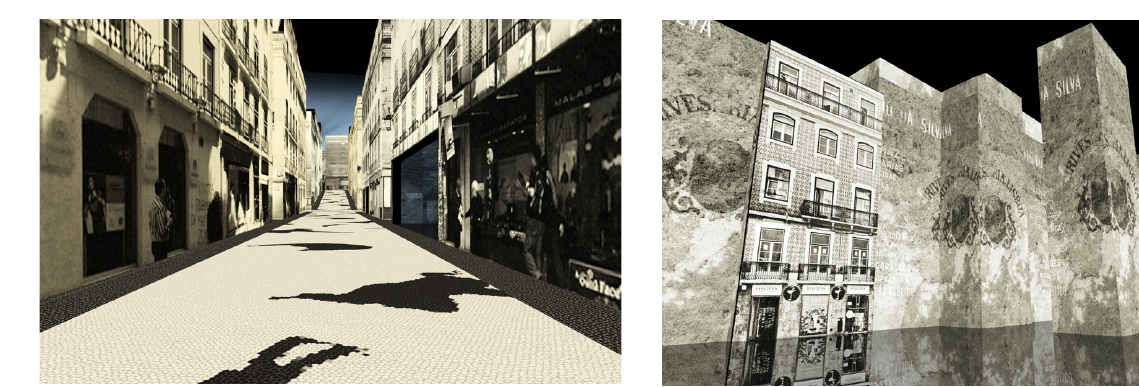
Fig. 5 Lisbon model: Baixa historical perpendicular road grid Fig. 6 Lisbon model: the historical facades